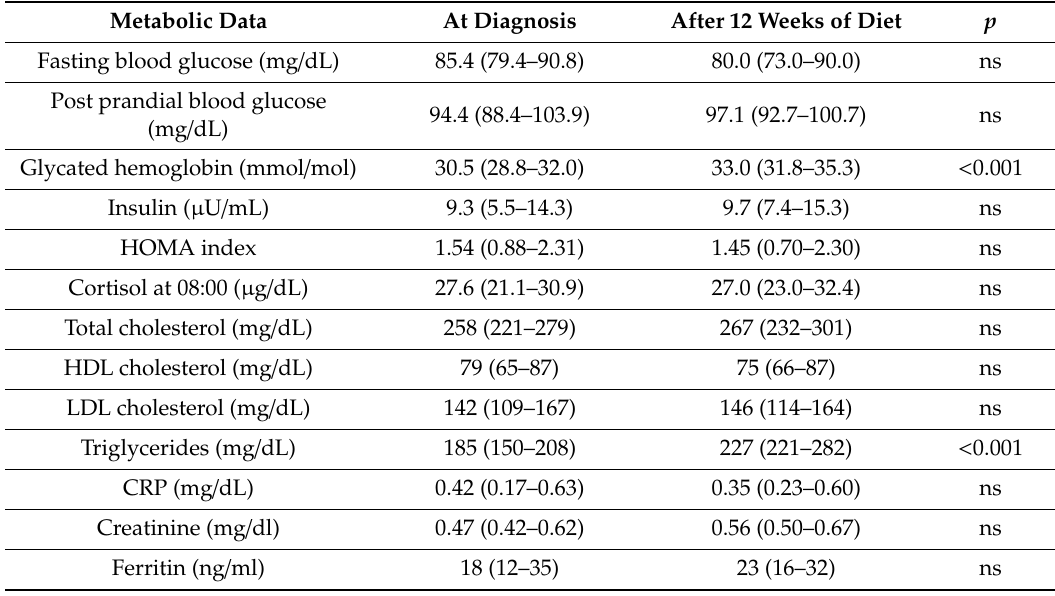
Table 2. Metabolic data of enrolled women at diagnosis of gestational diabetes mellitus and after 12 weeks of